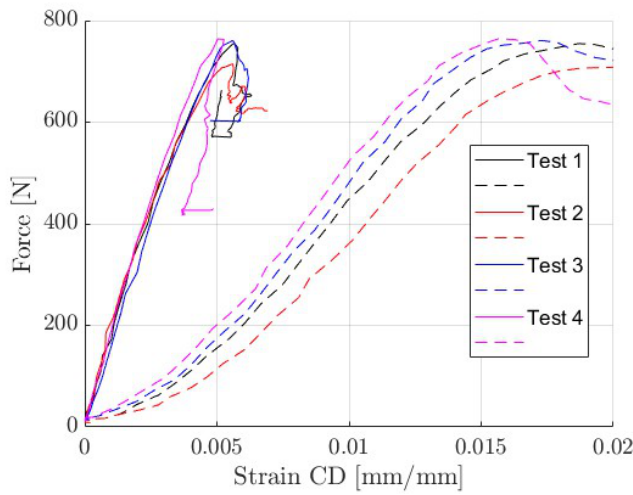
Figure 8. Force-displacement curves. Optical extensometry–solid lines; from machine crosshead– dashed lines.